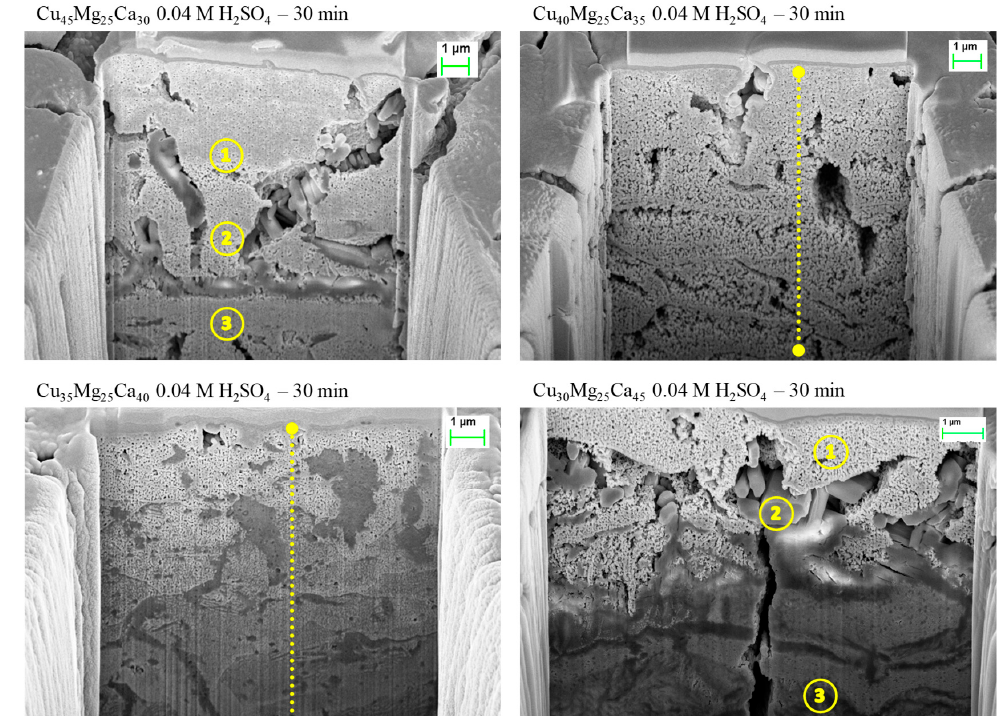
Figure 4. SEM images of the interior of dealloyed Cu 30 Mg 25 Ca 45 , Cu 35 Mg 25 Ca 40 , Cu 40 Mg 25 Ca 35 and Cu 45 Mg 25 Ca 30 ribbons. The yellow numbers and the dotted lines indicate the spots analyzed by EDS. The results of the composition analysis are displayed in Figure 5. XRD spectra of the as-quenched ribbons of Cu-Mg-Ca alloys. The crystalline phases producing the Bragg reflections are discussed in the main text.